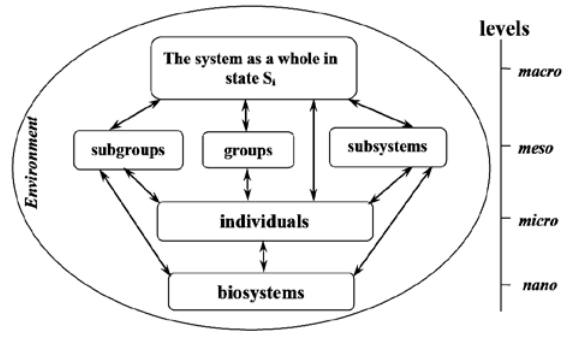
Fig.3. The scheme-model of the social system structure.